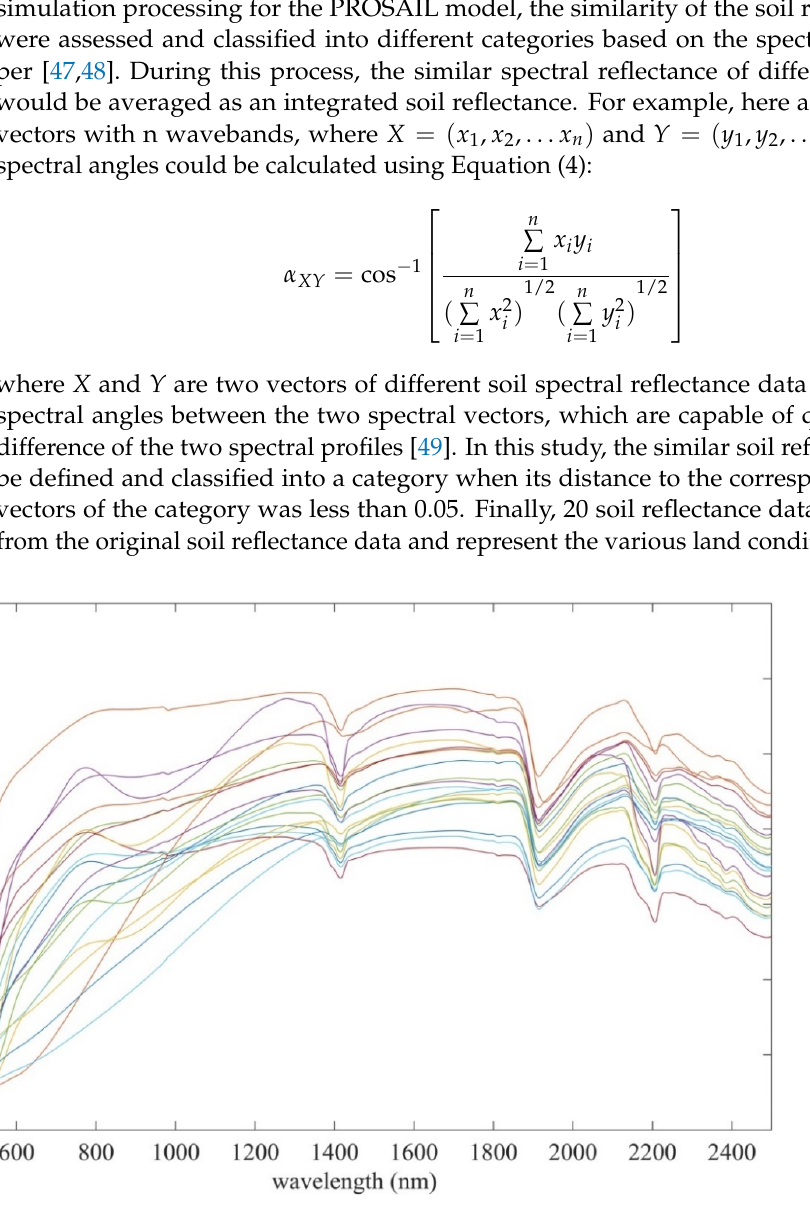
Figure 2. Twenty representative soil reflectance profiles after re-sample and